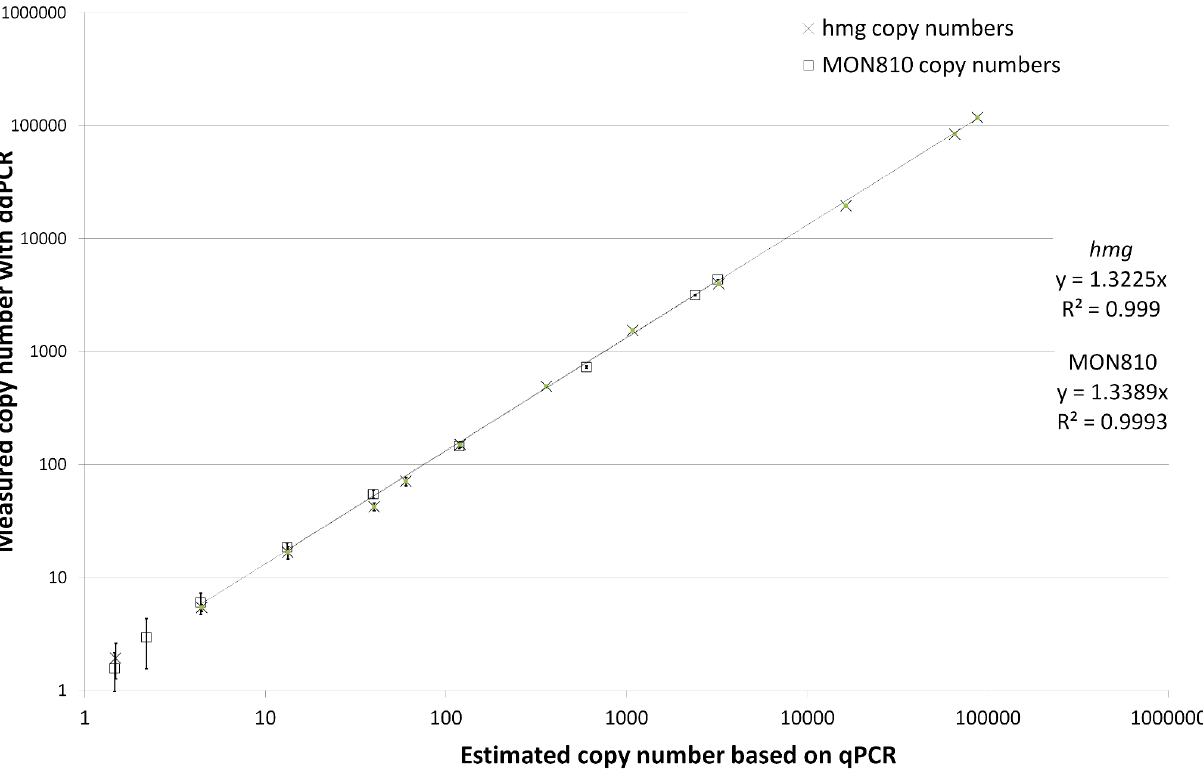
Figure 1. Dynamic range of the ddPCR duplex assay. Five replicates for each data point. Error bars represent the standard deviation between the five replicates at each target concentration.